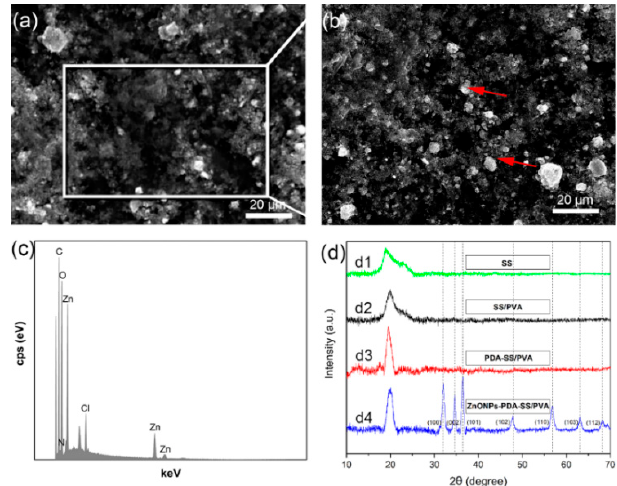
Figure 3. SEM characterization of ZnO NPs-PDA-SS/PVA film. ( a , b ) Field emission scanning electron microscope. ZnO NPs is indicated in red arrows. ( c ) A representative EDS spectrum of ZnO NPs-PDA-SS/PVA film. ( d ) The XRD profiles of sericin, SS/PVA, PDA-SS/PVA and ZnO NPs-PDA-SS/PVA films (d1–d4).